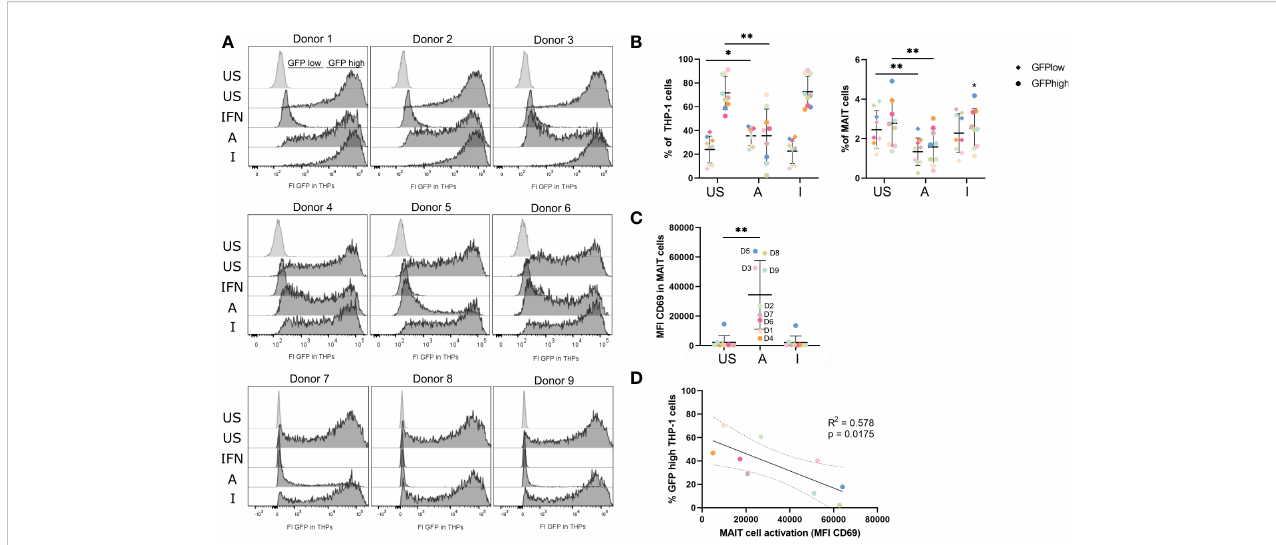
FIGURE 7 5-OP-RU-activated MAIT cells diminish intracellular viral levels in THP-1 cells. MAIT and THP-1 cells were stimulated for 20 hours with 50 ng/ml 5-OP- RU or Ac-6-FP. Subsequently, pre-stimulated cells were infected with VSV-eGFP (MOI 5) for 6 hours. Intracellular viral levels were quanti fi ed by measuring the GFP fl uorescence by fl ow cytometry. (A) Histograms of GFP fl uorescence of uninfected (light grey) and infected THP-1 cells (dark grey) are shown after pre-incubation with different MAIT cell donors. (B) Statistical evaluation of intracellular viral levels in THP-1 cells (left) and MAIT cells (right). (C) MAIT cell activation was determined by CD69 expression after 20 hours (D = Donor). (D) Correlation of MAIT cell activation and intracellular viral levels in THP-1 cells per donor. The solid line shows a linear correlation with a 95% con fi dence interval (dotted lines). R square (R 2 ) of linear regression and p-value for the scope to be non-zero are given. ( C+D ) Each dot representing an individual donor is shown in a different color corresponding to the color in (B) . Data from three independent experiments from nine donors are shown. Asterisks indicate signi fi cant differences determined by Wilcoxon matched-pairs signed rank test; p* < 0.05; p** < 0.01. Horizontal lines indicate mean ± SD. US = unstimulated; A = 50 ng/ml 5- OP-RU; I = 50 ng/ml Ac-6-FP; IFN = Interferon a B/D; FI = Fluorescence